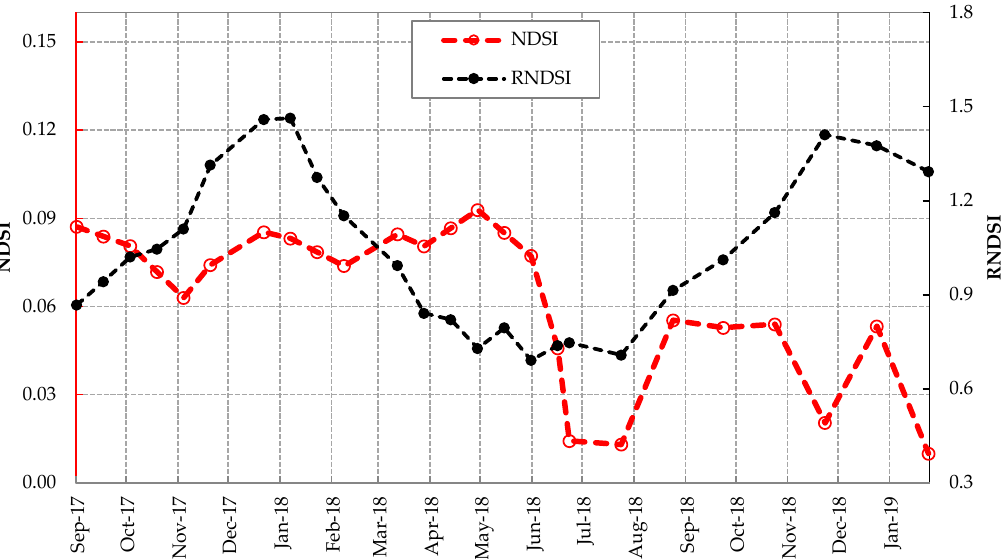
Figure 10. Comparison of mean NDSI values and mean RNDSI values of study site from September 2017 till February 2019.